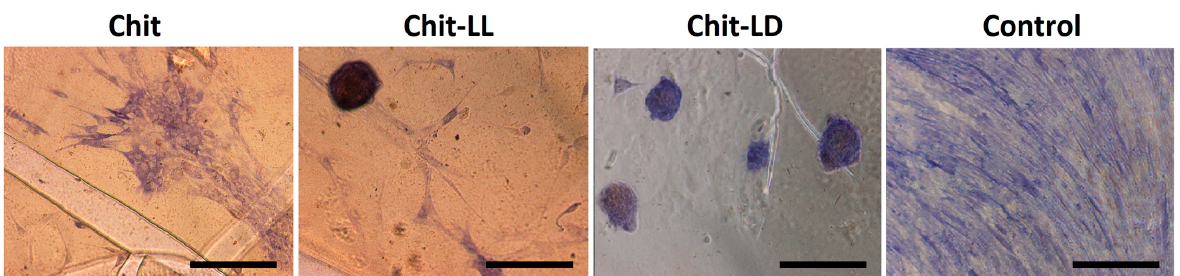
Figure 9. Induced osteodifferentiation of MSCs on the films from chitosan (Chit), chitosan-g-ol- igo(L,L-lactide) (Chit-LL), and chitosan-g-oligo(L,D-lactide) (Chit-LD). Evaluation of alkaline phos- phatase activity. Representative images of the histochemical reaction. The scale bar is 100 μ m (mag- nification ×100). Monolayer cell culture was taken as a control. MSCs were cultured in osteogenic medium (OS) for 7 days.